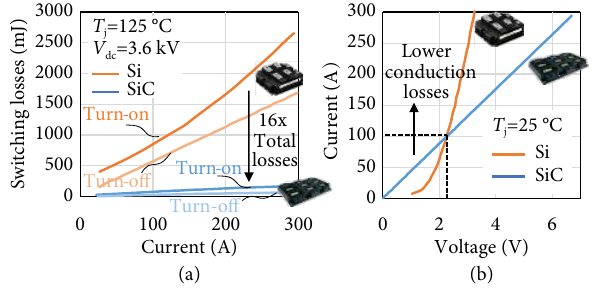
Fig. 2 Loss comparison between the Si IGBT [30] and SiC MOSFET [25, 28] power modules. (a) switching losses, (b) output characteristics or conduction